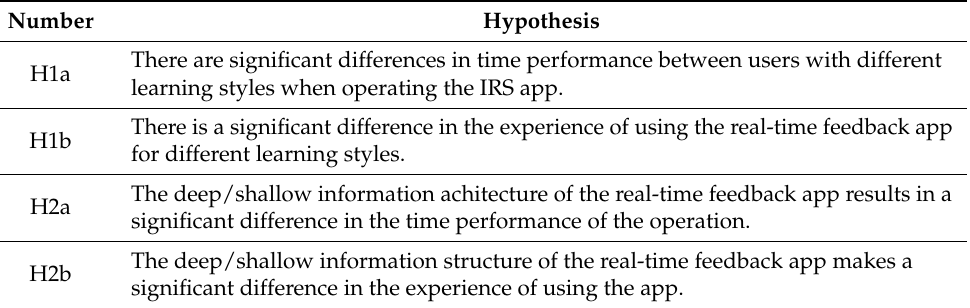
Table 3. Research Table 3. Research hypotheses.